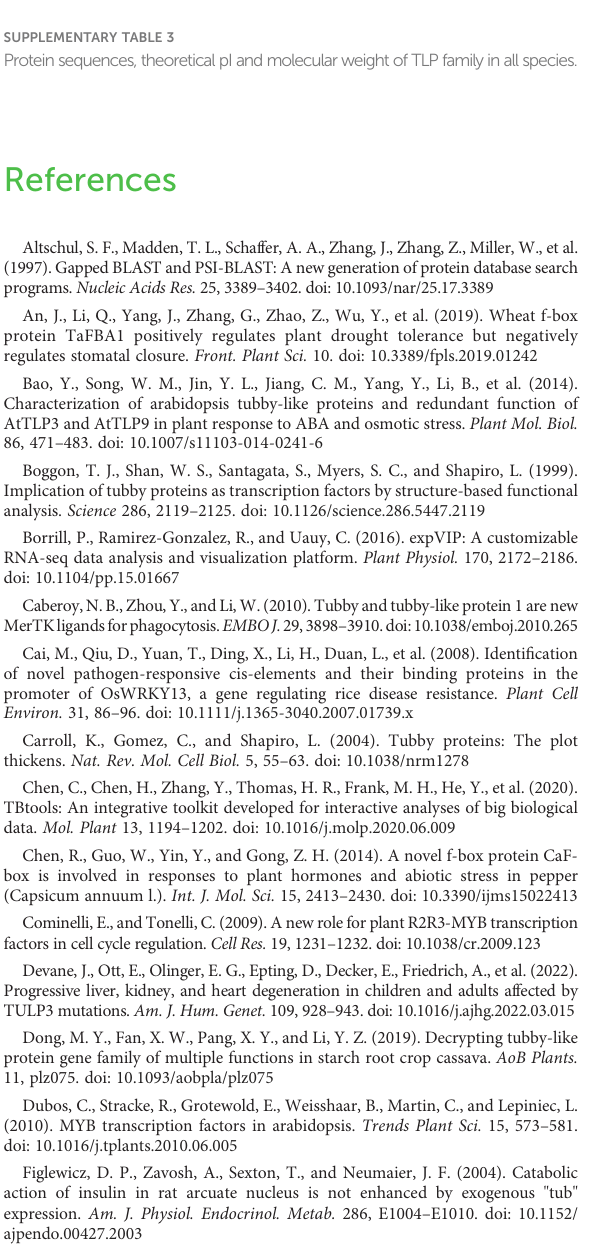
multiple tissues. SUPPLEMENTARY TABLE 8 The expression values of OsTLPs in different stresses. SUPPLEMENTARY TABLE 9 Primers used in this